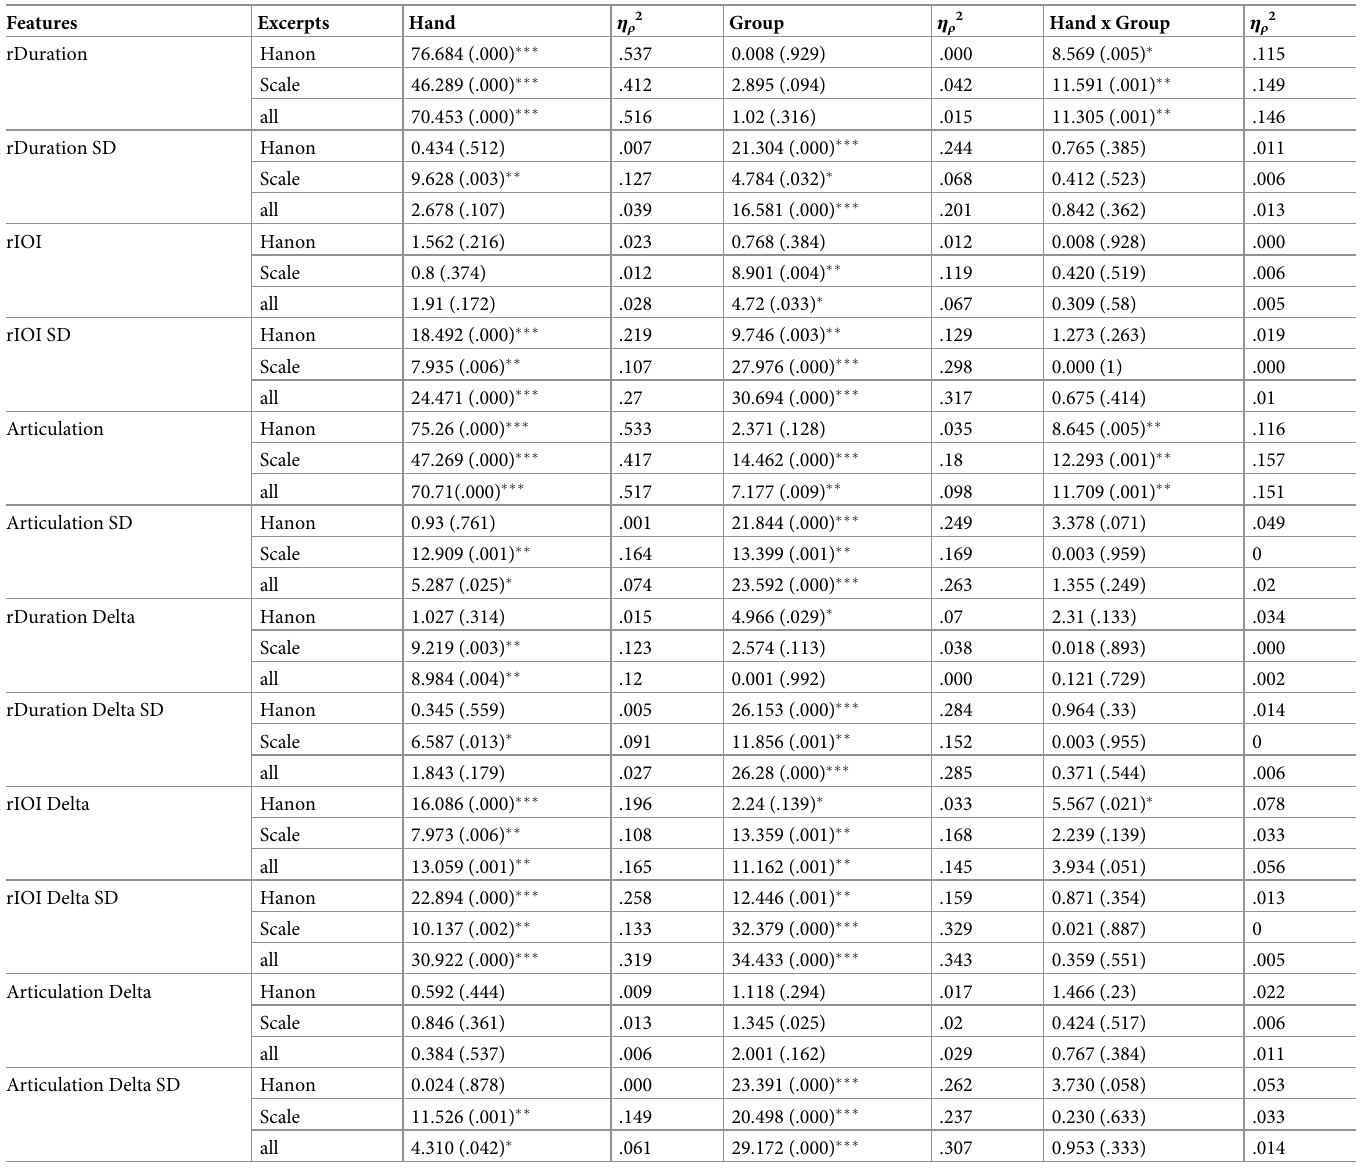
Table 2. F -values and p -values in temporal